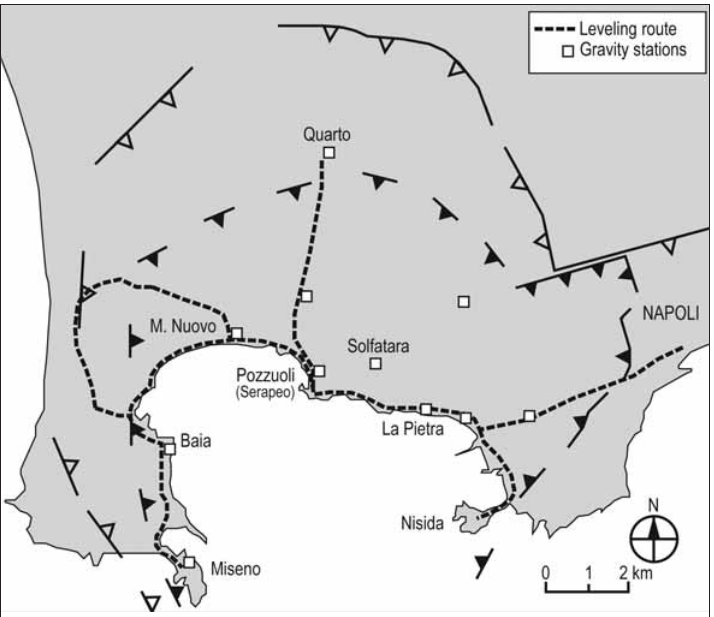
Fig. 1. Map of Campi Flegrei caldera showing the outer rim (open triangles) and the inner caldera (full trian- gles), the leveling lines (dotted) were surveyed during 1982-1984 unrest episode, while the squares represents the gravity stations active in that